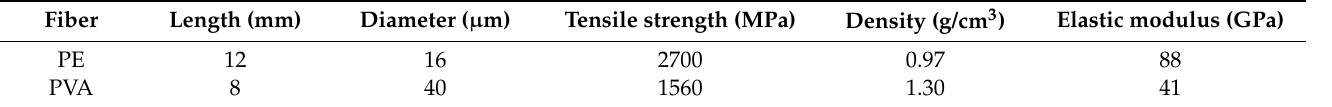
Table 2. Physical properties of PE and PVA fibers.